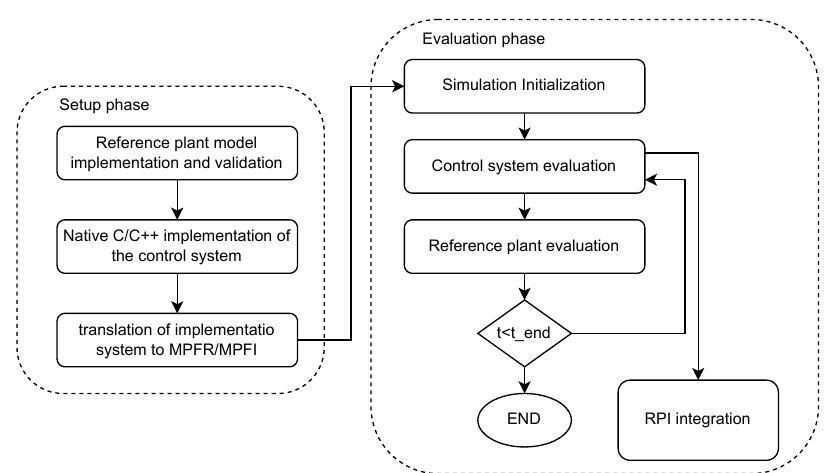
Figure 2. Flow diagram of the proposed numerical robustness analysis